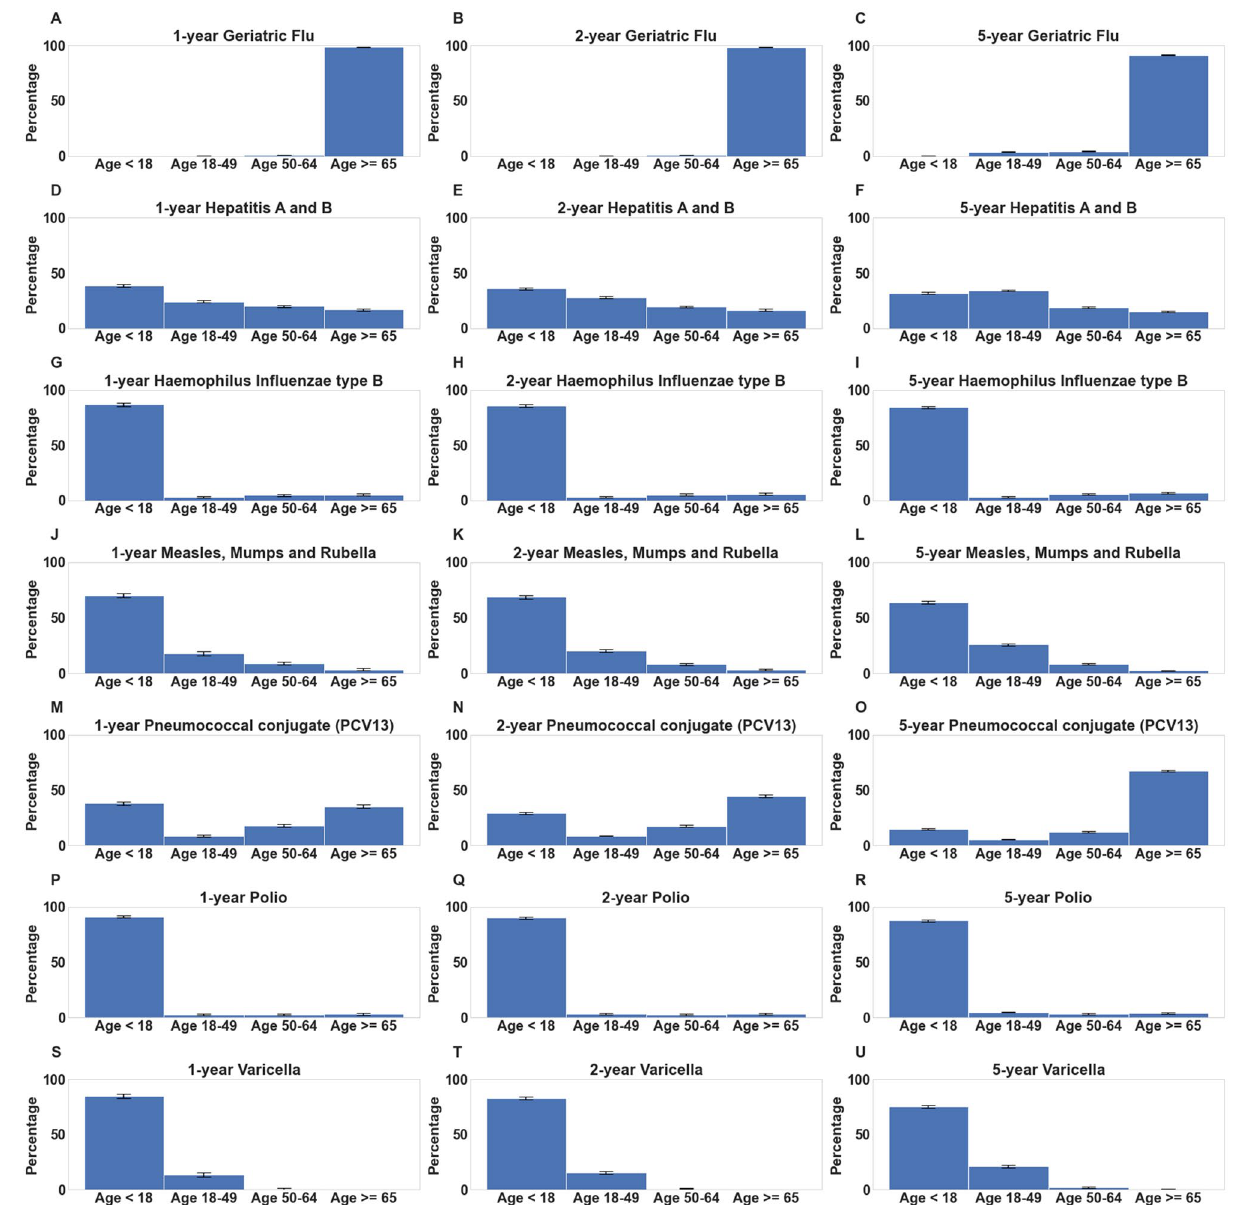
Figure 4. Age distribution plots for vaccinated cohorts. Distributions of age in cohorts of individuals who received vaccines associated with lower SARS-CoV-2 rates. For each vaccine, percentages of vaccinated individuals within age brackets (< 18, 18–49, 50–64, 65+ years) are shown along with 95% confidence intervals. Includes age distributions for the following vaccines for the past 1, 2, and 5 year time horizons: ( A – C ) Geriatric Flu vaccine, ( D – F ) Hepatitis A/Hepatitis B (HepA-HepB), ( G – I ) Haemophilus Influenzae type B (HIB), ( J – L) Measles-Mumps-Rubella (MMR), ( M – O ) Pneumococcal Conjugate (PCV13), ( P – R ) Polio, ( S – U )